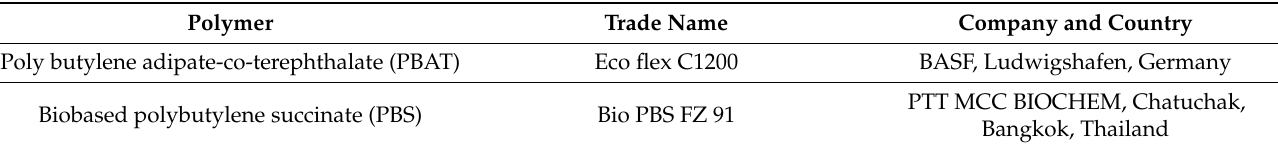
Table 1. Biopolymers used in this study for the development of composites.